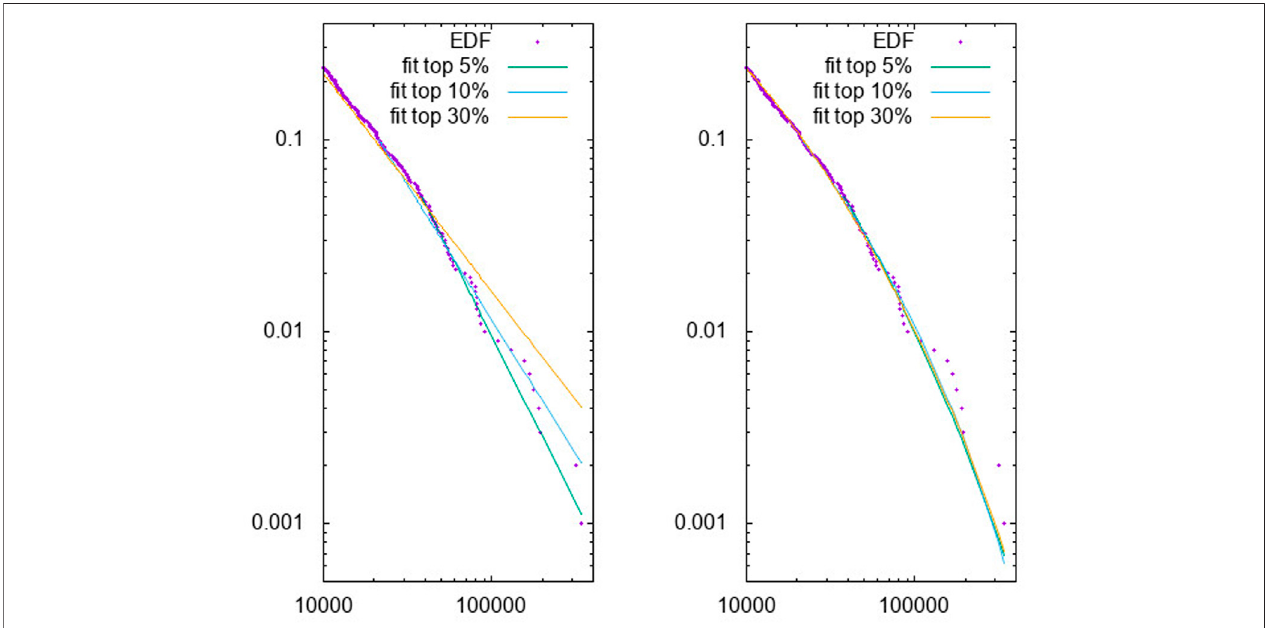
FIGURE 2 | Distribution of the largest worldwide fi rms in 2006 according to Fortune 500 (revenues in millions of dollar). The maximum likelihood estimation of the upper tail obtained using 5%,10% and 30% of the available data is plotted for the Pareto Type I (left) and Pareto Type III (right) distribution.